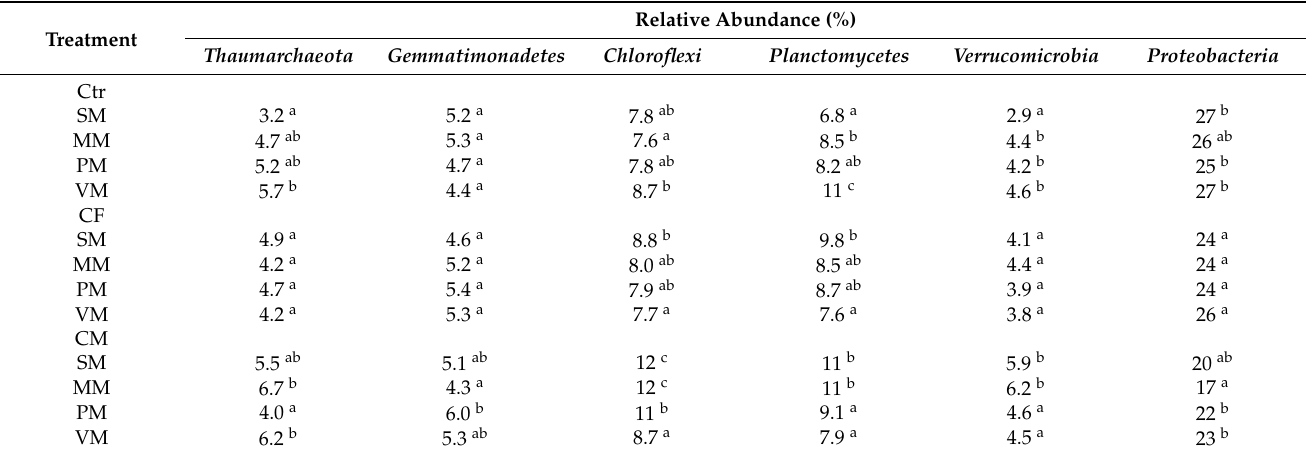
Table 2. The relative abundance of prokaryotes at the phylum level showed significant interactions between legume species and fertilizer